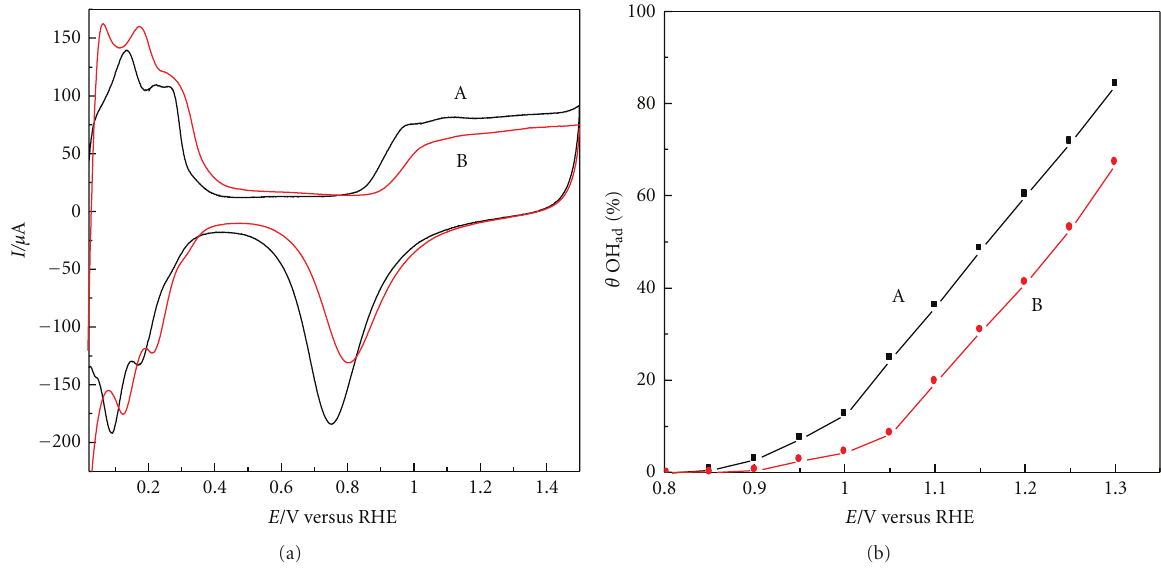
Figure 6: (a) CVs at GCE-supported (A) Pt nanoparticles and (B) Pt 53 -on-NiCo nanostructure surfaces in 0.5 M H 2 SO 4 solution purged with N 2 . Scan rate: 10mVs − 1 . (b) Surface coverage of hydroxyl ( θ OH ) calculated based on the corresponding OH ad formation region shown in